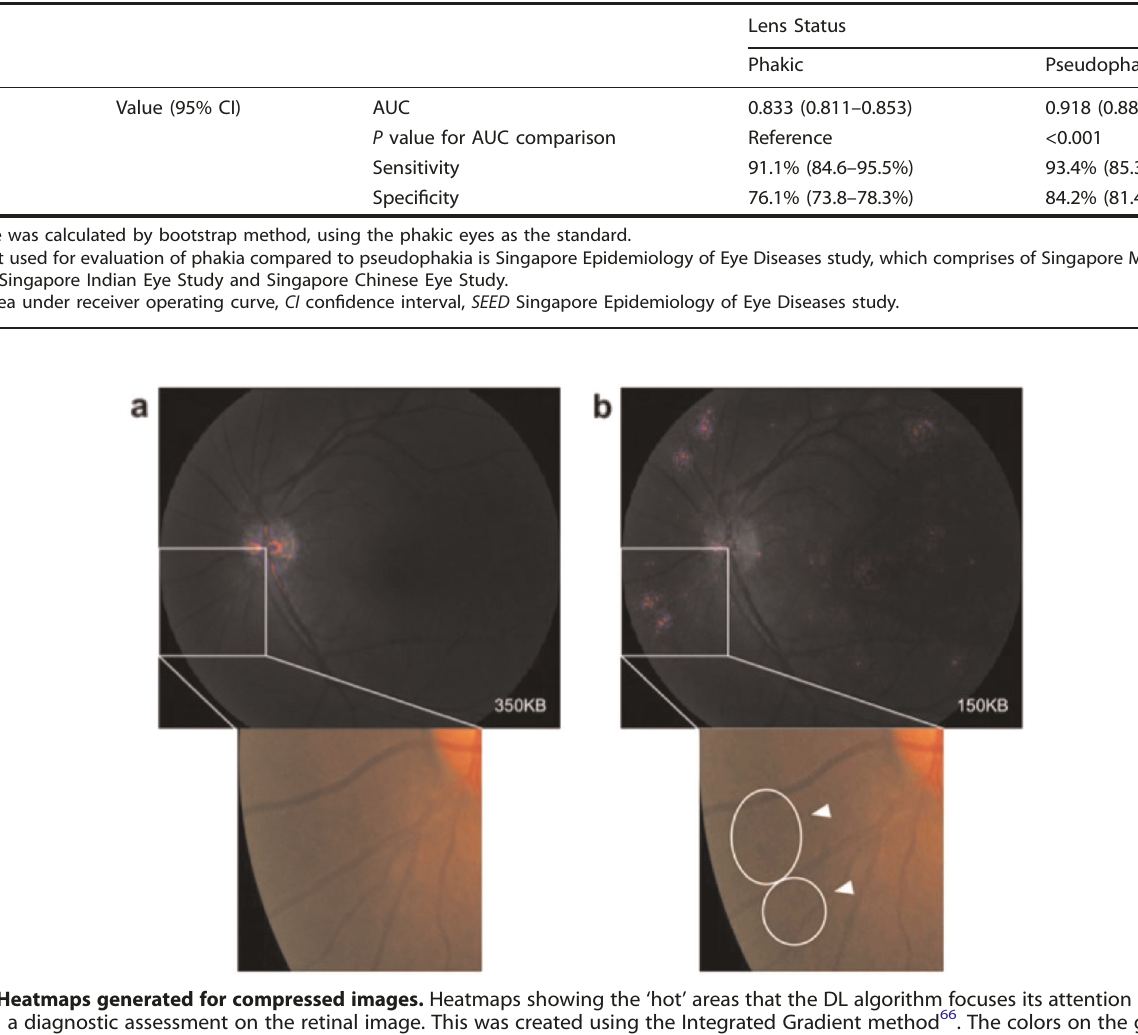
Table 6. Effect of image-related factors speci fi cally previous cataract surgery.